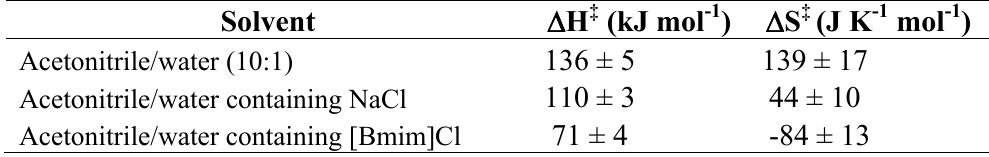
Table 2. Activation parameters for the reaction outlined in Scheme 3 in the solvent systems specified. Uncertainties quoted are standard